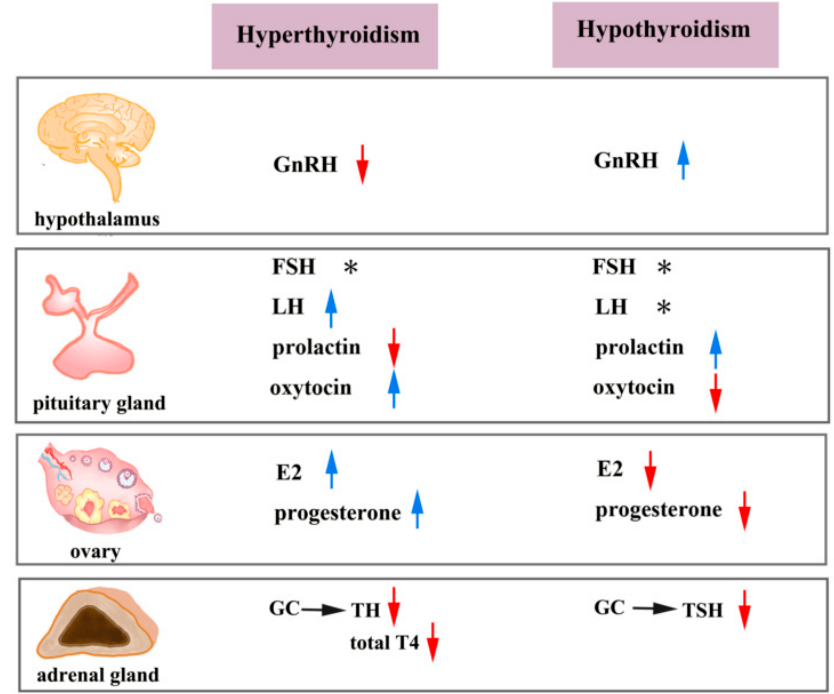
Figure 3. Effects of hyperthyroidism and hypothyroidism on serum hormone levels in women. Thyroid dysfunction can result in changes in the reproductive hormone secretion. The horizontal arrow represents upregulation, whereas the downward arrow indicates that hyperthyroidism and hypothyroidism decrease serum hormone levels. The upward arrow indicates that hyperthyroidism and hypothyroidism increase serum hormone levels. The asterisk indicates that the changes of hormone levels are inconsistent among various sources in the literature. GnRH, gonadotropin-releasing hormone; FSH, follicle-stimulating hormone; LH, luteinizing hormone; E2, estradiol; GC, glucocorticoid; TH, thyroid hormone; T4, thyroxine; TSH, thyroid-stimulating hormone. The red arrow indicates decreased hormone levels. The blue arrows indicate increased hormone levels. Asterisks indicate inconsistencies in the literature.